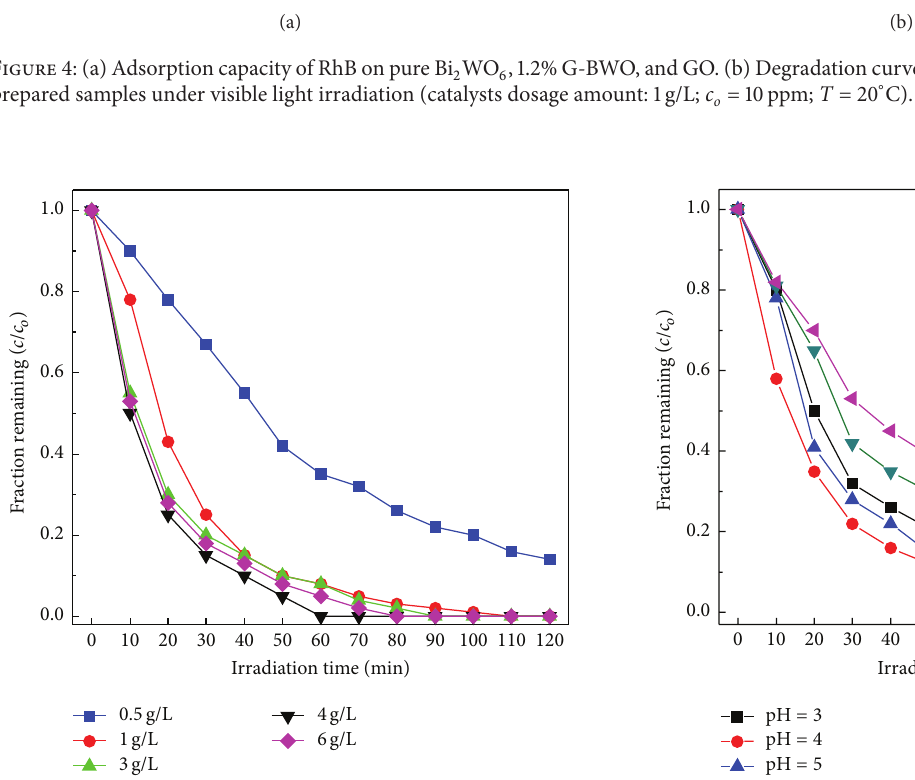
Figure 6: Removal efficiencies of RhB with different pH of initial solution in the presence of 1.2% G-BWO under visible light irradia- = 10ppm; T = 20 ∘ C). tion (catalyst dosage: 1g/L; c o